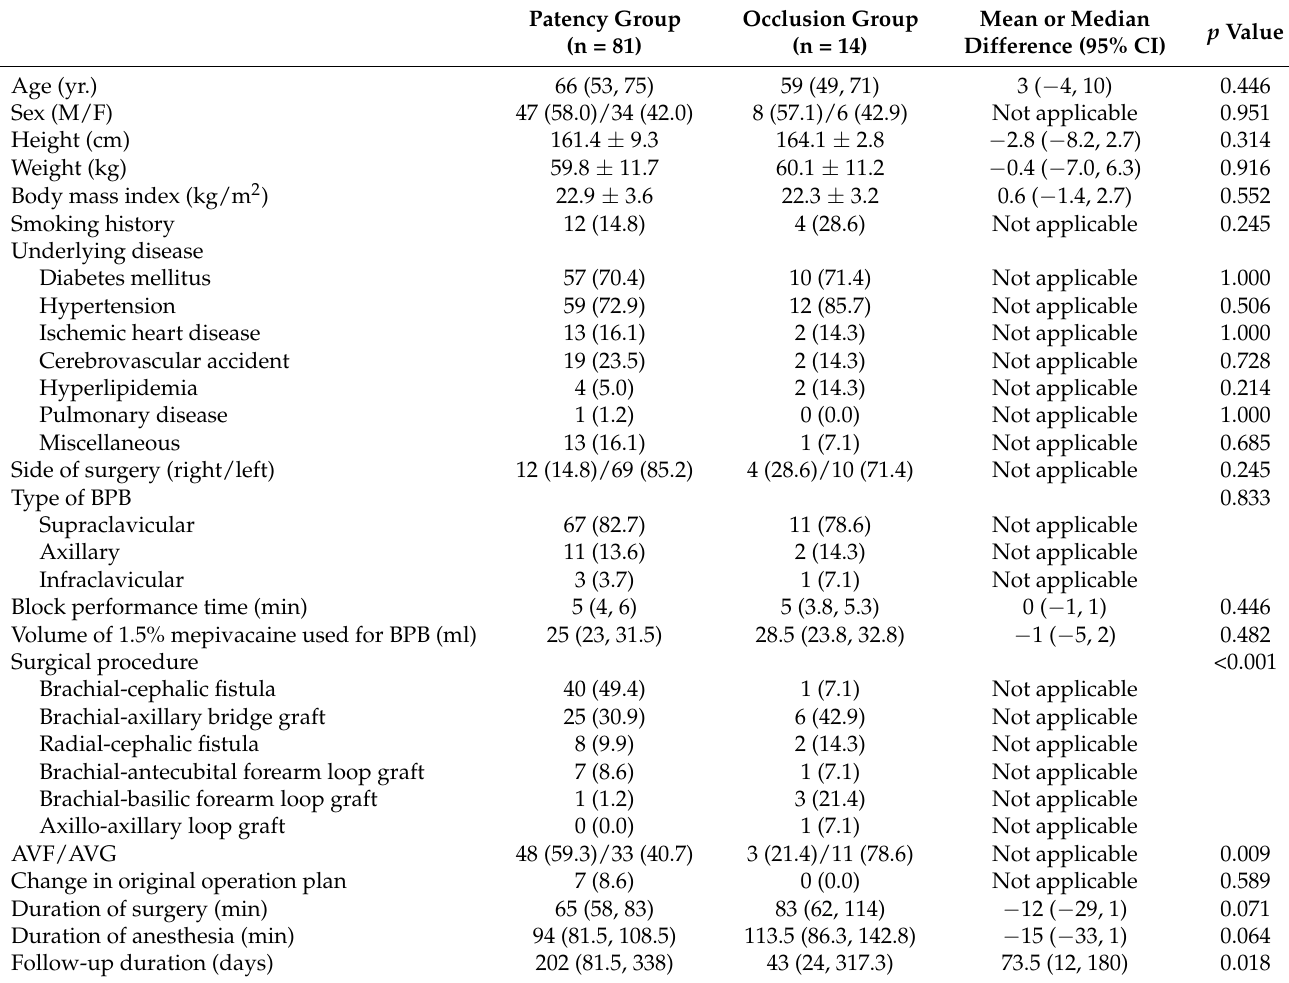
Table 1. Patient